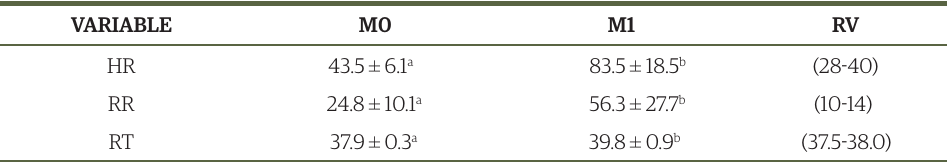
table 1. Mean and standard deviations of the heart rate (HR - bpm), respiratory rate (RR - mpm) and rectal temperature (RT - °C) of Mangalarga Marchador Horses before (M0) and after (M1) marcha exercise, followed by their respective reference values (RV).